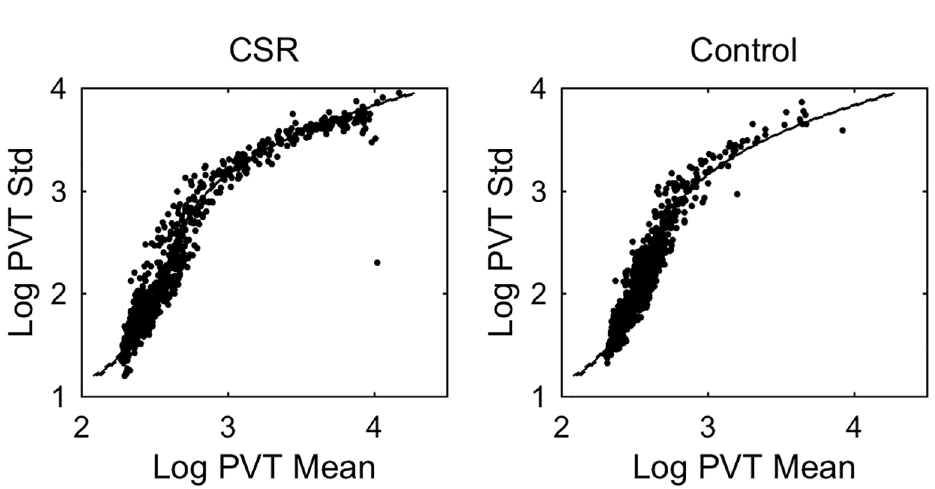
Fig 4. The relationship between PVT standard deviation and PVT mean . Data are shown for Chronic Sleep Restriction (CSR) and Control conditions. Data from both conditions demonstrate a robust relationship between the standard deviation and mean of the Psychomotor Vigilance Task (PVT). Logarithms of each variables are plotted to the wide ranges that the data span. Each data point represents one 10-min session. The same polynomial fit is shown to data in both plots with 95% confidence intervals indicated by dashed